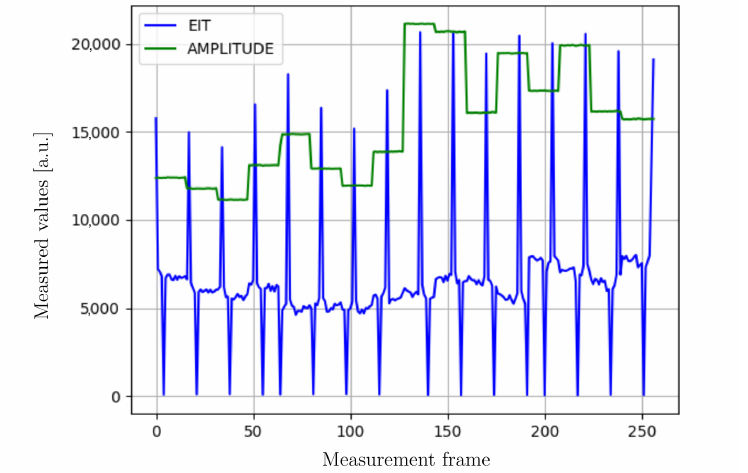
Figure 4. An example of a measurement data frame. The data frame consists of 256 components of the recorded EIT voltages and the applied voltage for the injection current (marked with a green